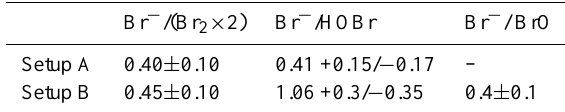
Table 2. The ratio of detected Br − to Br 2 , HOBr and BrO. The errors are estimated from the uncertainties in Br 2 , HOBr, BrO and Br − measurements and the variance (one standard deviation) of the individual ratio measurements. Br − /(Br 2 × 2) Br − /HOBr Br − / BrO Setup A 0.40 ± 0.10 Setup